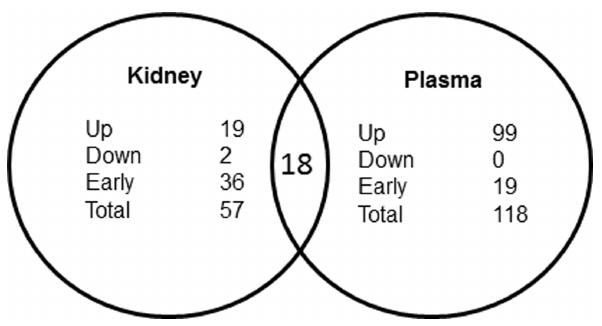
Figure 4. Pattern of microRNA modulation in kidneys and plasma of mice undergoing ischemia-reperfusion. While multiple microRNA species were modulated in the kidneys and in plasma after ischemia-reperfusion, 18 microRNAs were modulated in both compart- ments in a time-dependent manner. Up , increased expression; Down , decreased expression; Early , modulated at 3 hours and returned to the Sham level at 24 hours.